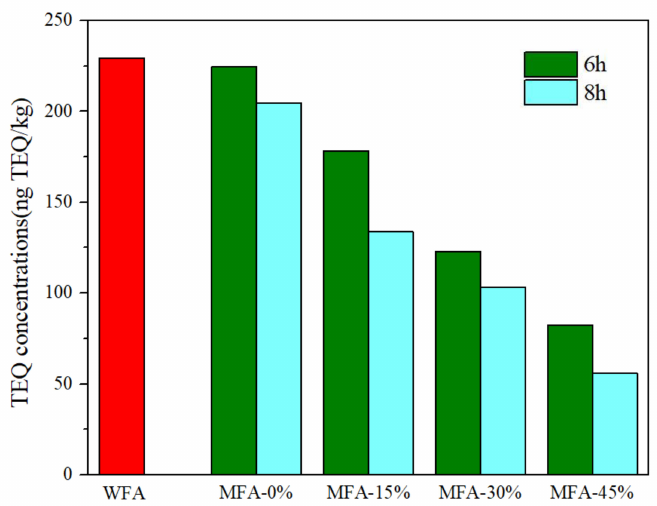
Figure 3. TEQ concentrations of the MC-treated fly ash.